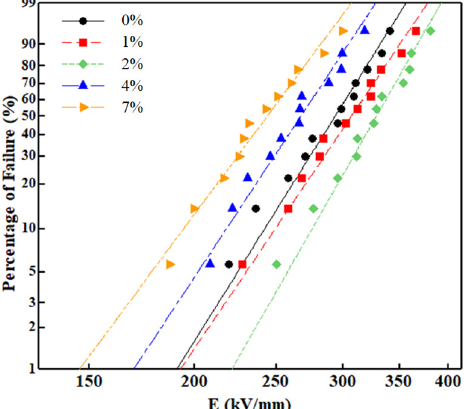
Figure 5. Dielectric loss of LDPE and Al 2 O 3 -h-BN/LDPE composite specimens as a function of fre- quency.